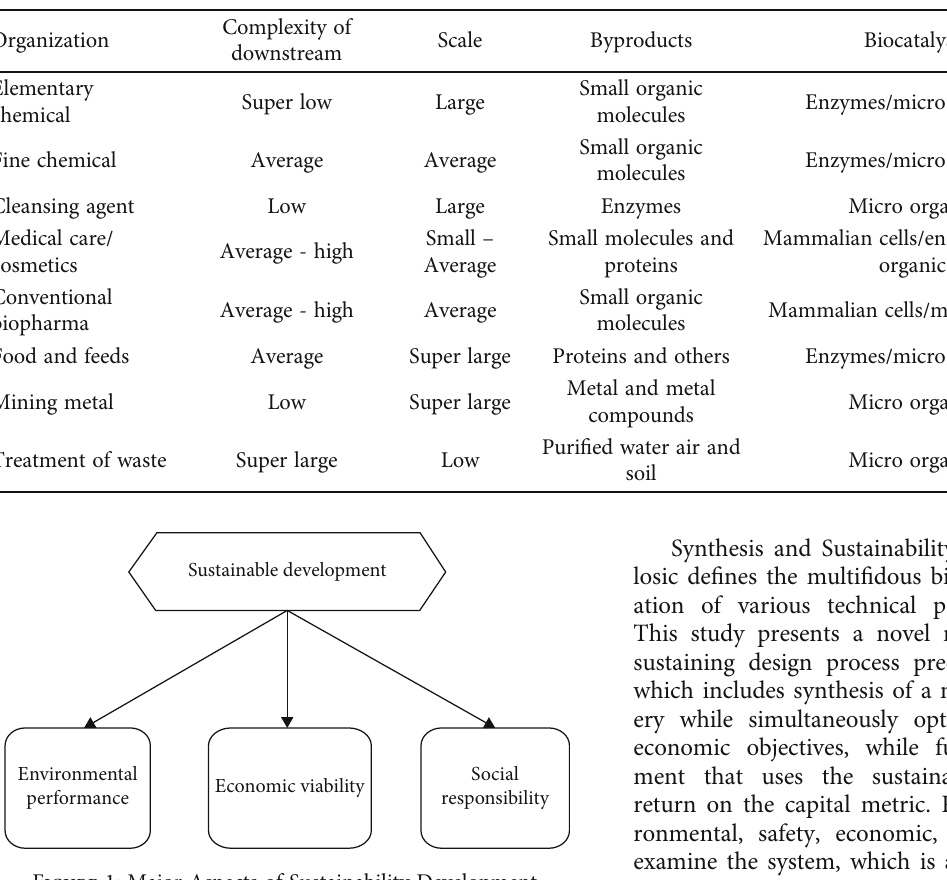
Table 1: Process Industry vs Microorganisms.